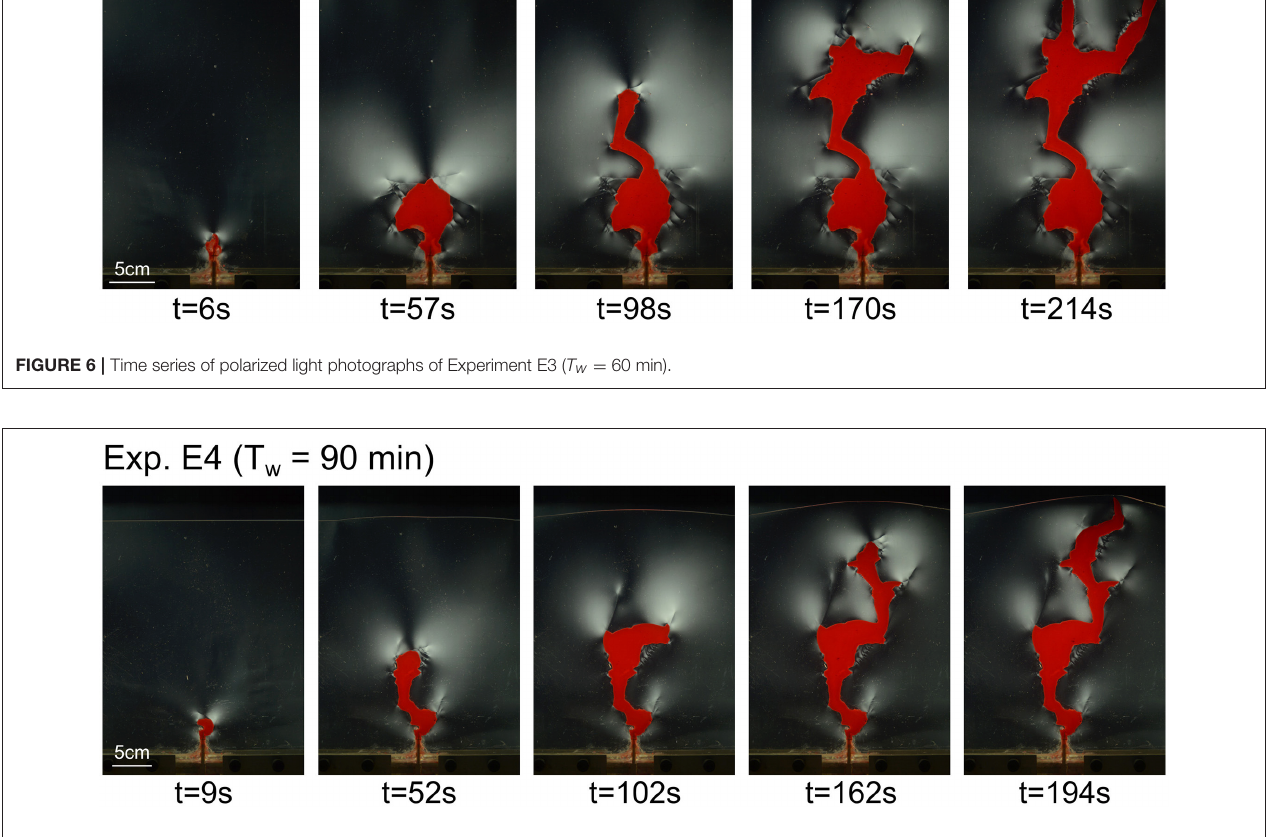
FIGURE 7 | Time series of polarized light photographs of Experiment E4 ( T w = 90 min).